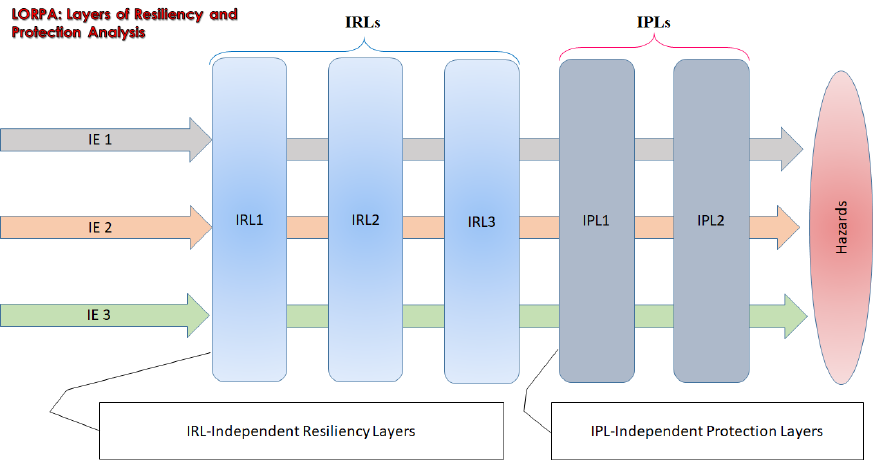
Figure 6. Integrated resiliency and protection layers.